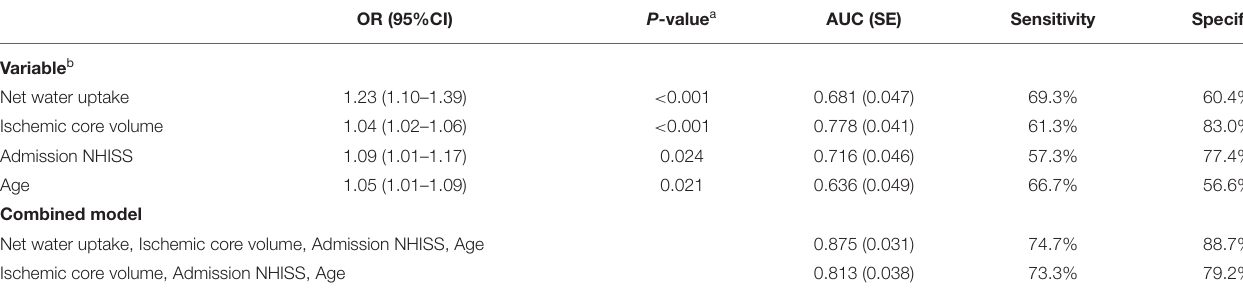
TABLE 3 | Binary logistic regression and ROC curve analysis to probability of prognosis after anterior circulation infarct.